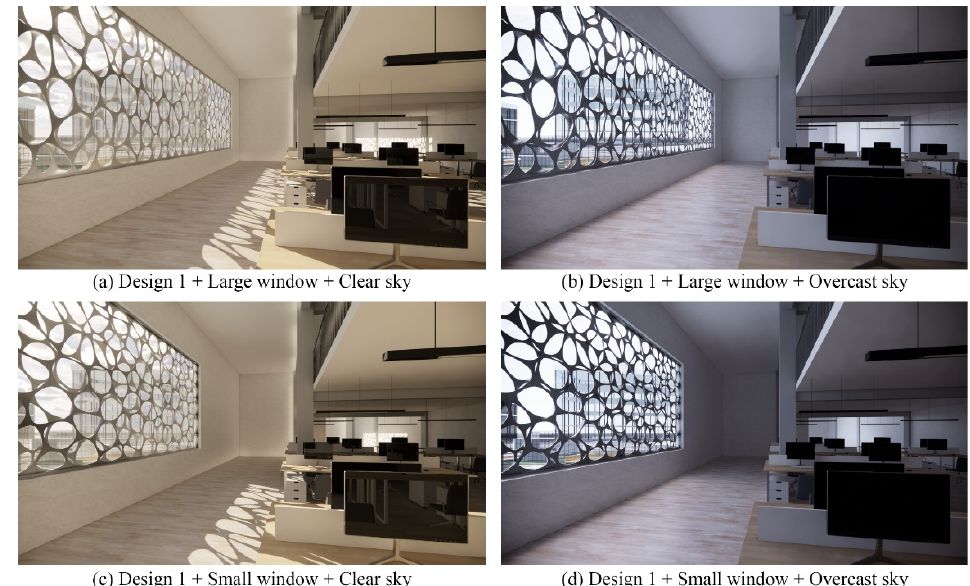
Figure 3. Four scenes for Design One with the combination of window size and sky type.